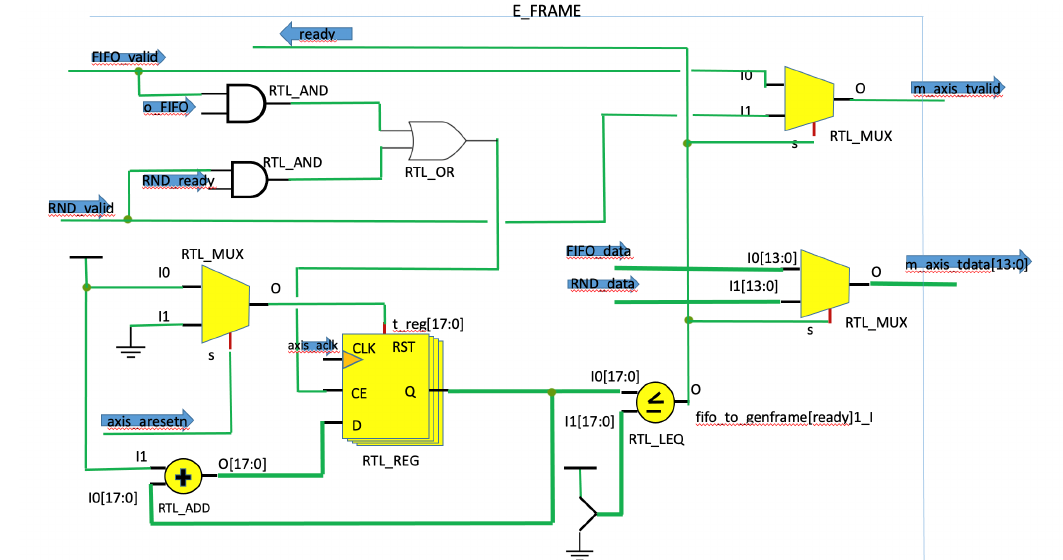
Figure 19. PART III—physical layer frame RTL block